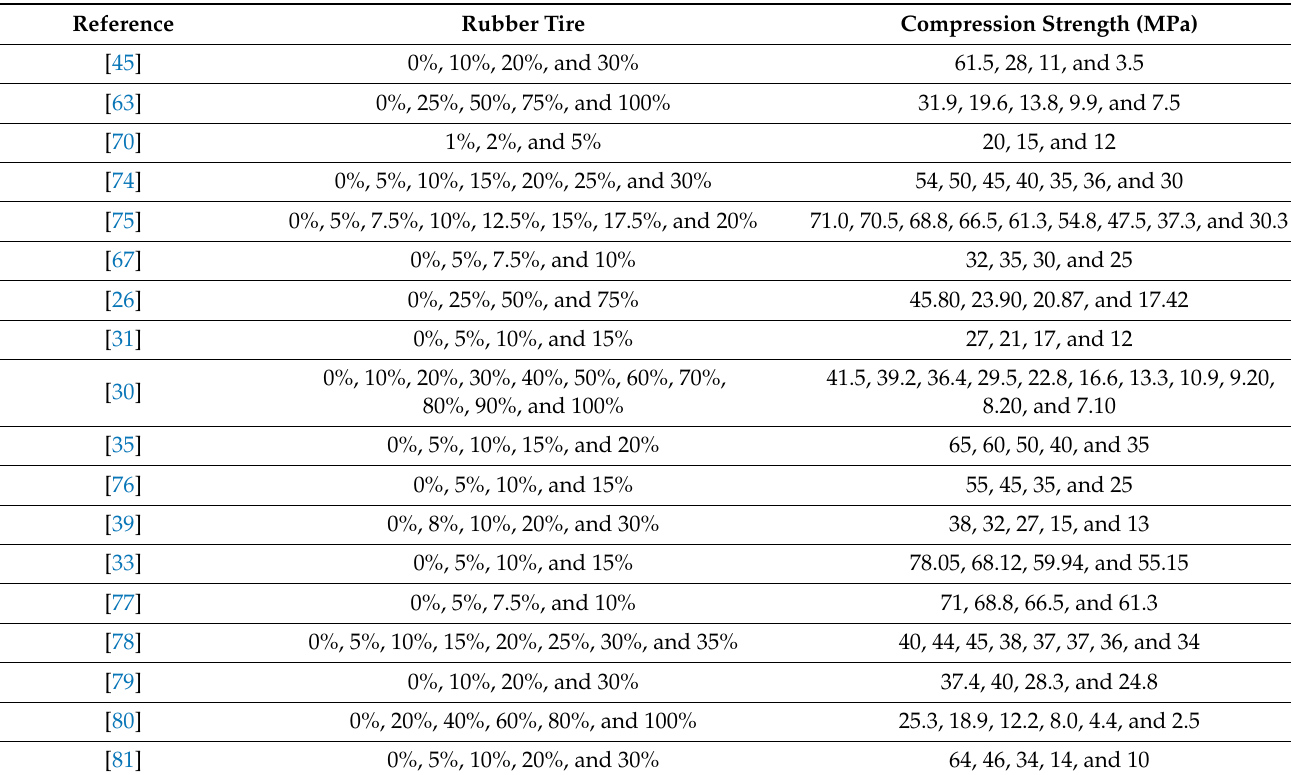
Table 2. Summary of compressive strength.